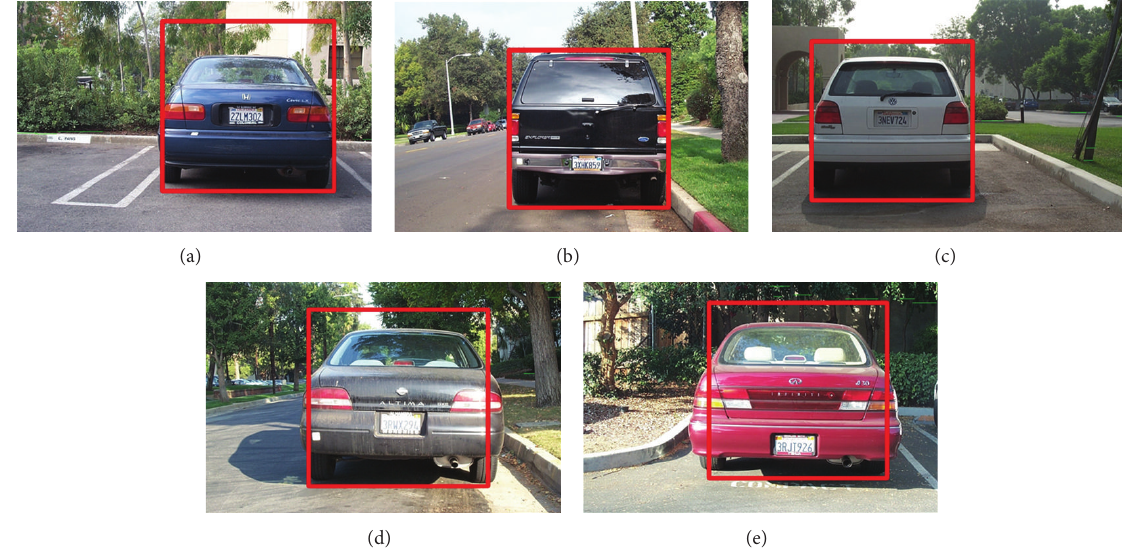
Figure 11: Detection results on Caltech Rear public vehicle images.